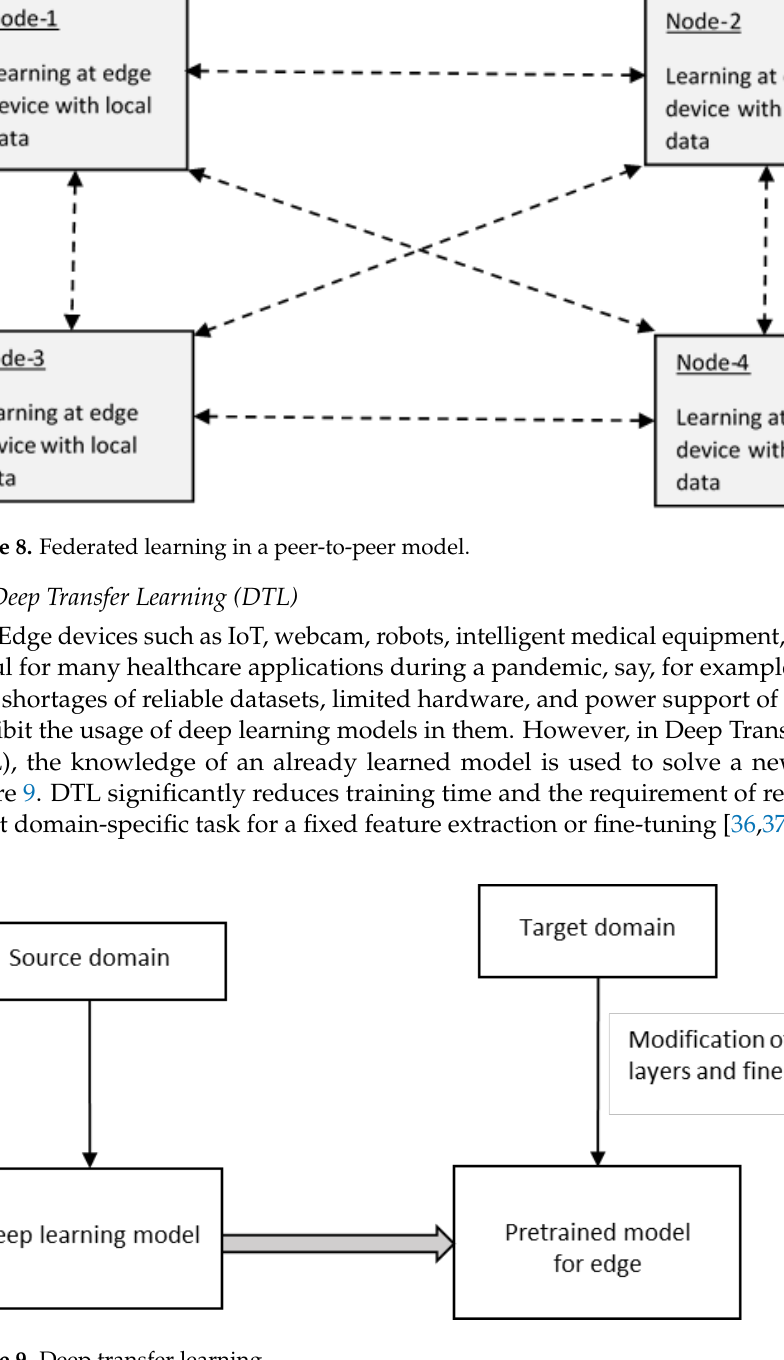
Figure 9. Deep transfer learning.